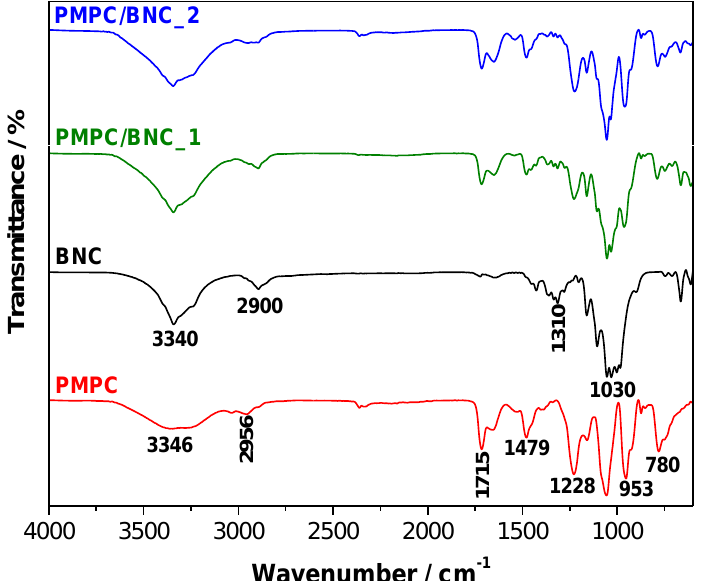
Figure 2. ATR-FTIR spectra of cross-linked PMPC, neat BNC, and nanocomposites PMPC/BNC_1 and PMPC/BNC_2.